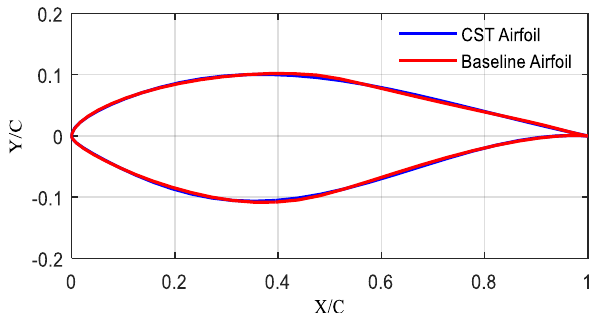
Figure 1. National Renewable Energy Laboratory (NREL) S809 airfoil generated by class shape transformation (CST) parameterization.